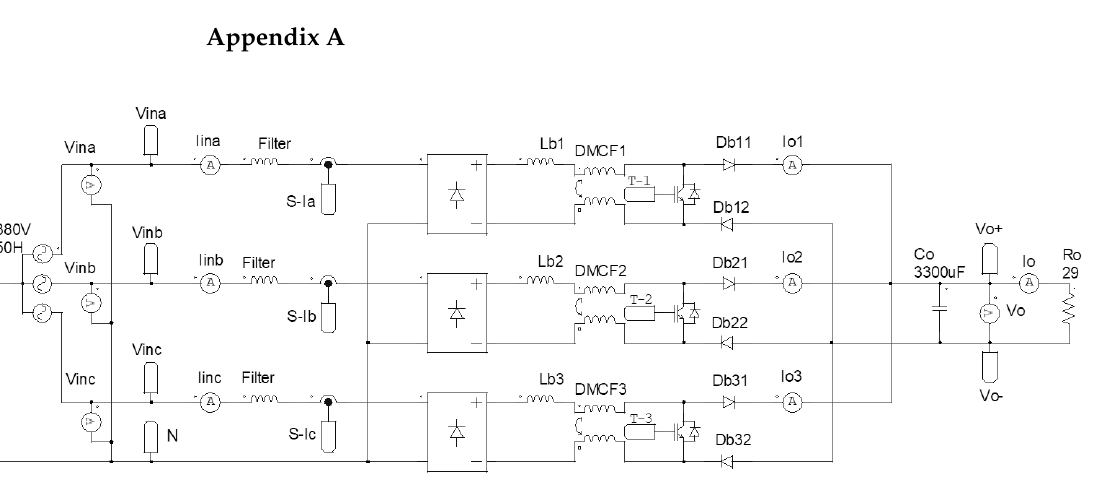
Figure A1. Power Figure A1. Power circuit.